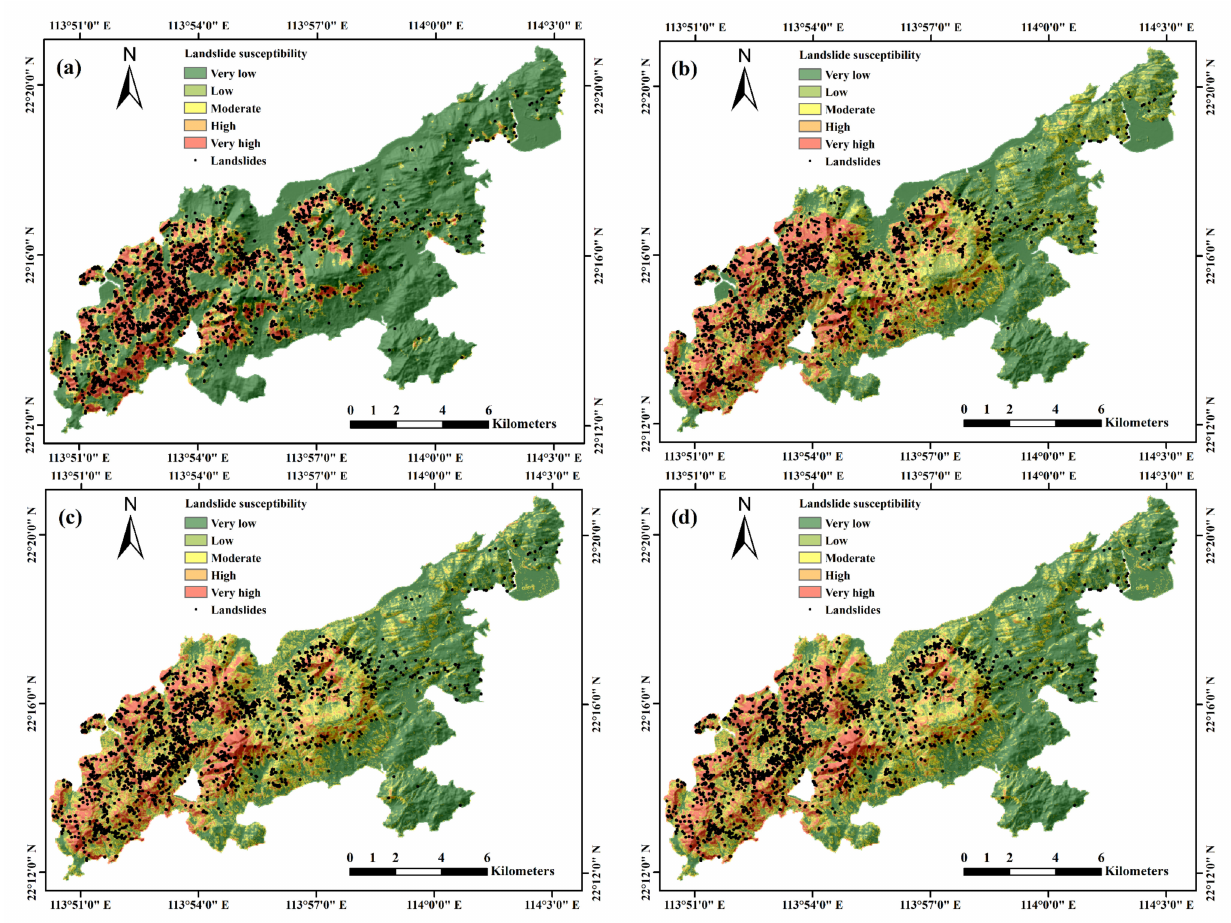
Figure 11. Landslide susceptibility maps of Lantau Island using ( a ) convolutional neural network, ( b ) random forest, ( c ) logistic regression, and ( d ) support vector machine.